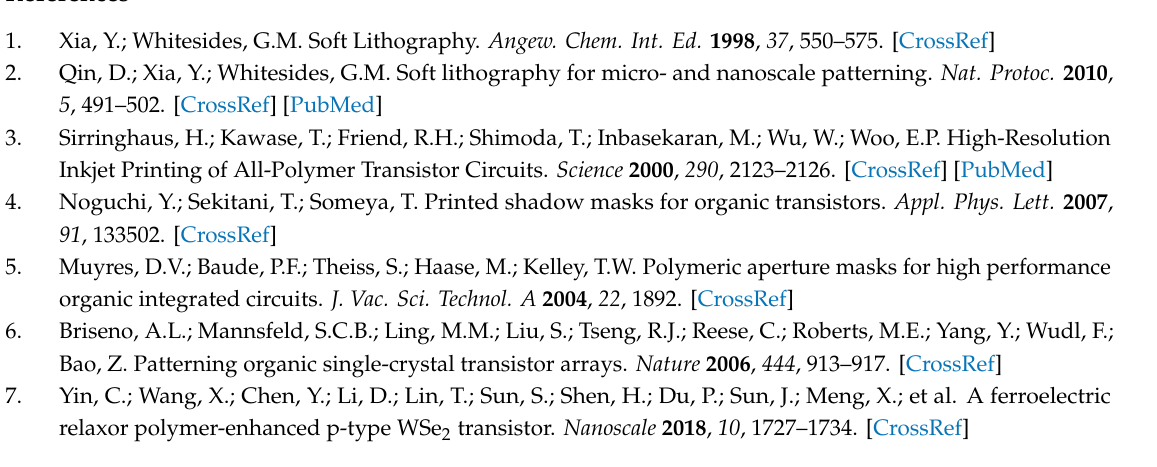
Figure S1: MB fiber-based shadow masking technique, Figure S2: Transfer characteristic curves and linear mobility plot of another WSe 2 PMOS, Figure S3: The load-line analysis for CMOS inverter